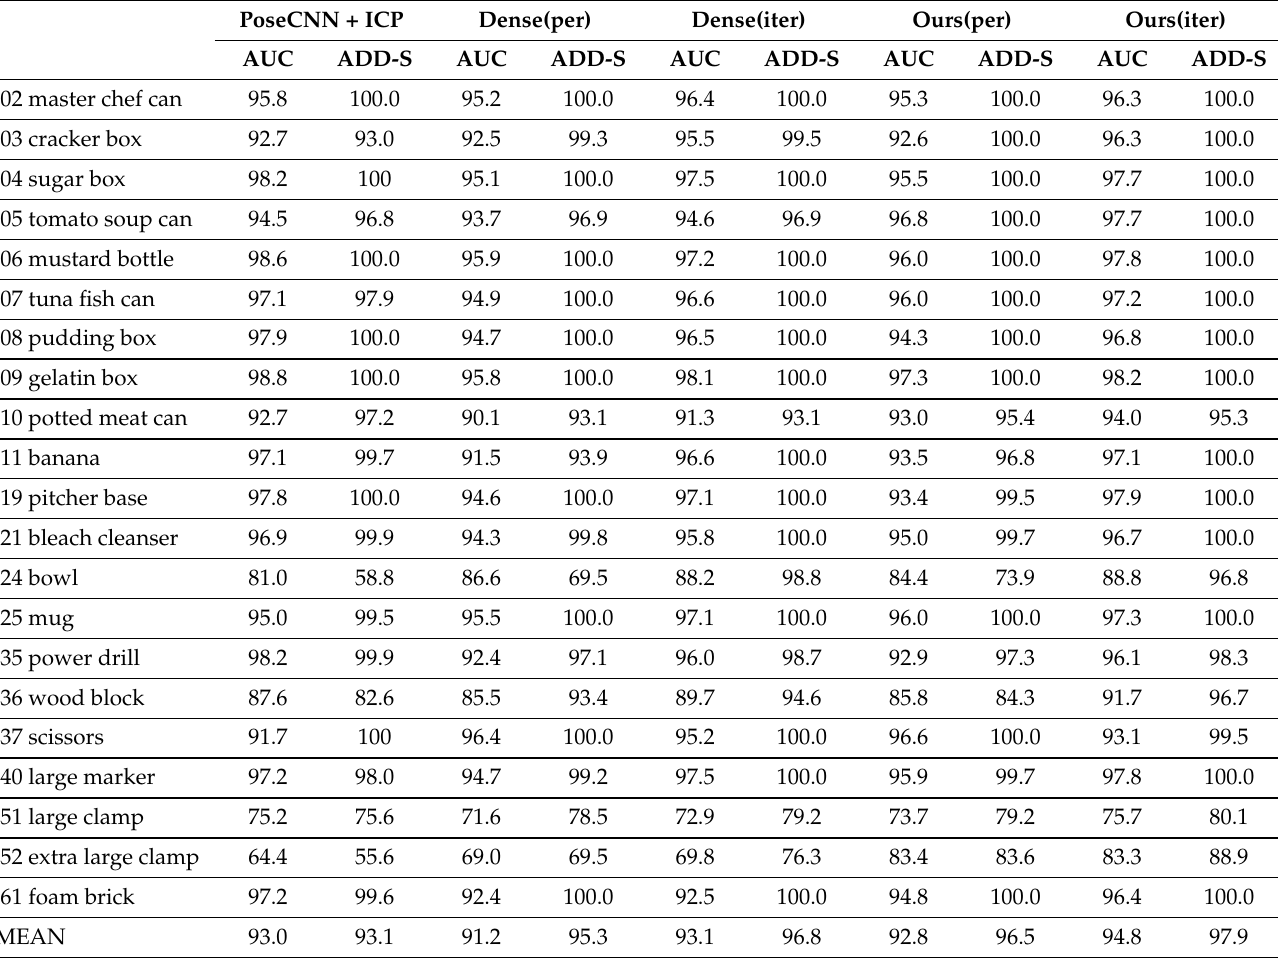
Table 3. Quantitative evaluation of pose estimation on YCB-Video dataset.